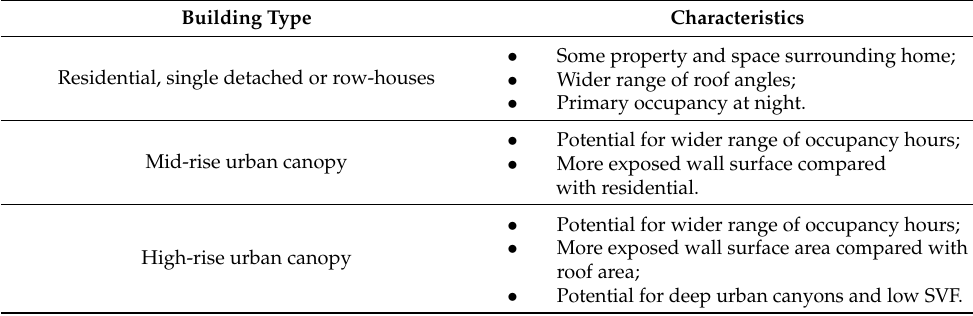
Table 2. Characteristics to consider in different urban